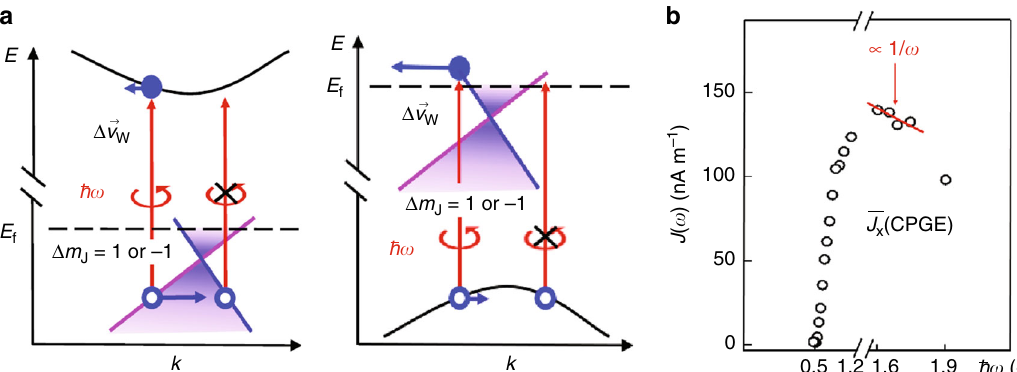
Fig. 7 Schematic of CPGE and its dependence on the incident photon energy. a The asymmetric population or depopulation of the tilted Weyl cones leading to an average band velocity of Δ v w results in a non-zero charge current using circularly polarized light. The dashed line represents the Fermi level 25 . During the optical transitions, the total angular momentum should be conserved, and its quantum number m J satis fi es the relation: Δ m J = 1 or − 1, depending on the helicity of the pump pulse. The left is for excitations from the linear Weyl bands to the high-lying massive states. The right is for excitations from the low-lying massive bands to the linear Weyl bands. b The DC sheet current density J is expected to be proportional to 1/ ω in the near-infrared spectral region according to our theoretical model, as indicated by the red solid